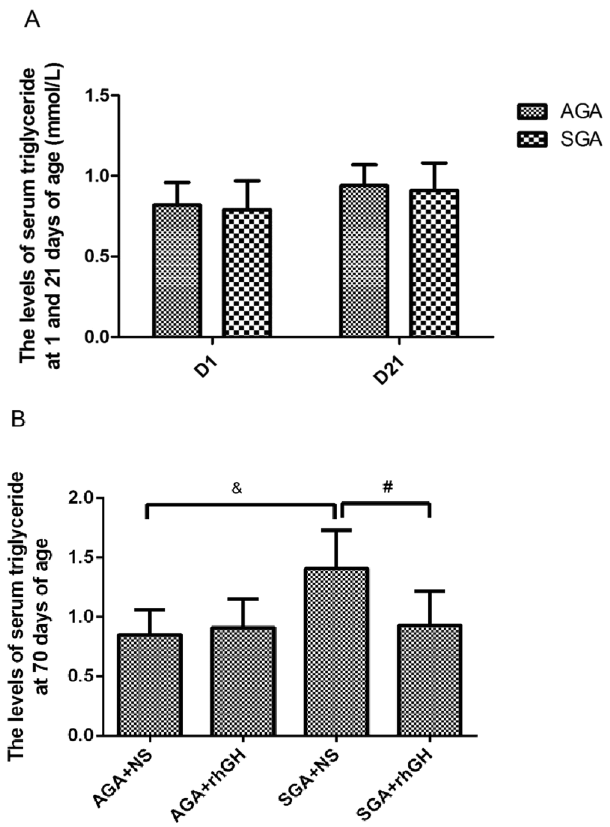
Figure 2. The levels of serum triglyceride before and after GH or NS treatment. Results are expressed as the mean ± S.E.M. Statistical differences between the groups are given as follows: &p < 0.05: AGA + NS vs SGA + NS; #p < 0.05: SGA + NS vs SGA + rhGH. n = 8 per experimental